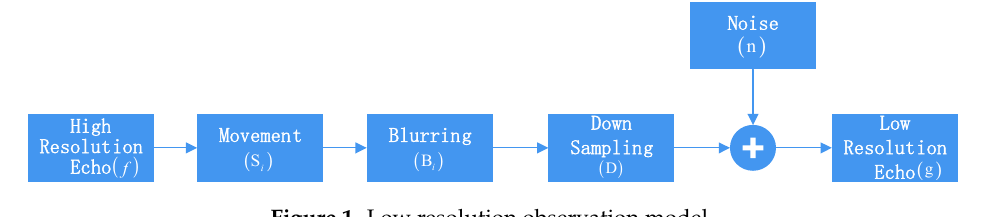
Figure 1. Low resolution observation model.